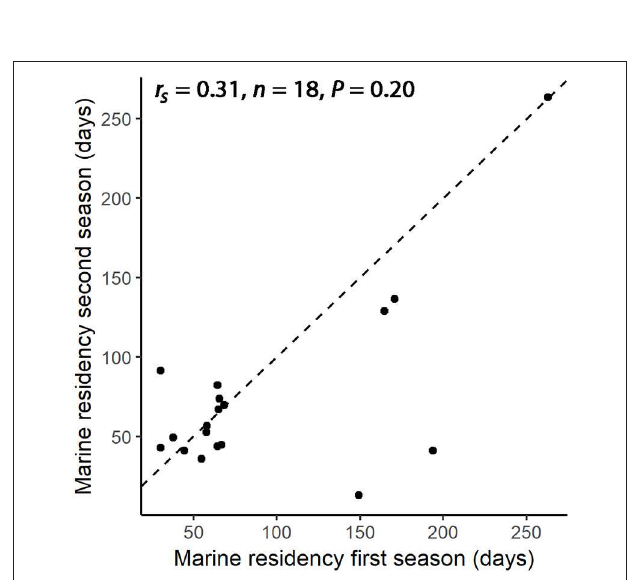
FIGURE 7 | Duration of tagged individual marine residence (days) during first (x-axis) and second (y-axis) year of tracking. Stippled line indicates the 1:1 line. Summary statistics ( r s and P -values) are calculated by Spearman’s correlation